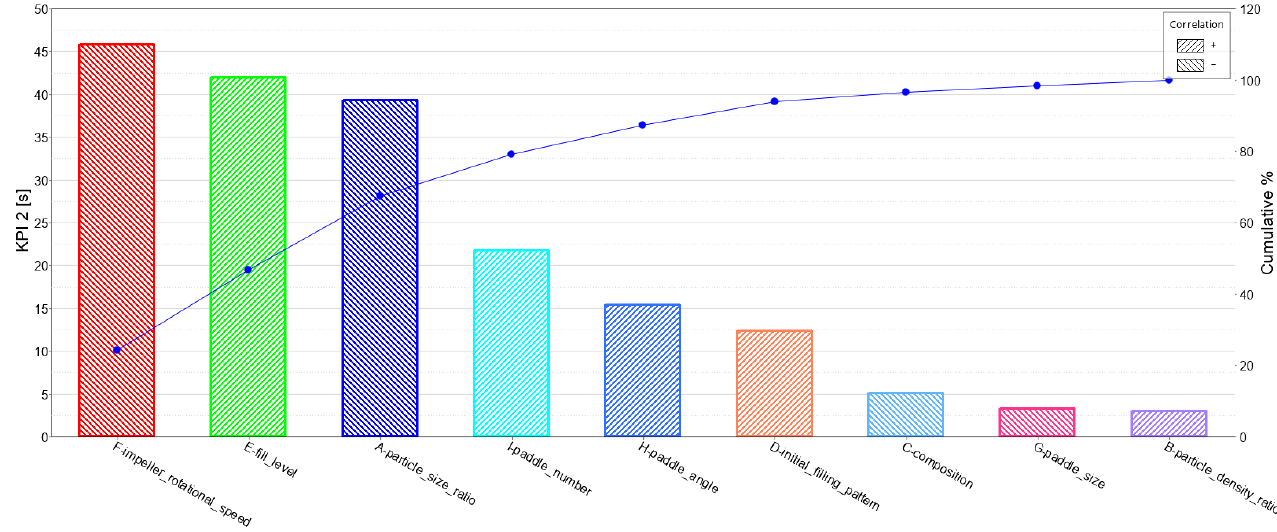
Figure 8. Pareto plot for KPI 2 mixing time. Table 7. Analysis of variance (ANOVA) results of KPI 2 mixing time.